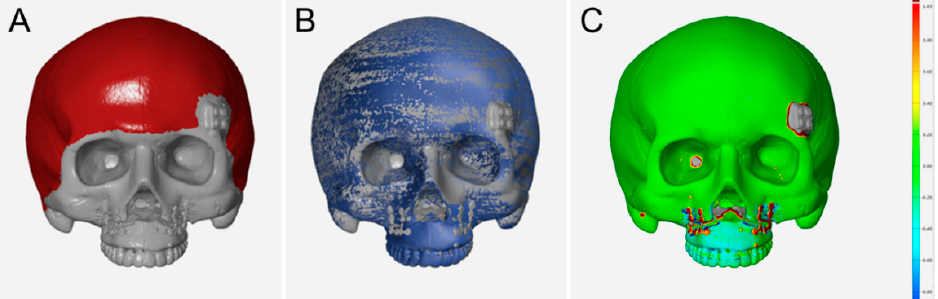
Figure 6. Superimposition of the postoperative 3D skull model registered with scanned dentition with the virtual surgical outcome. ( A ) Selection of the outer cortex of the cranium for local best-fit registration; ( B ) after superimposition of the two skull models; ( C ) surface comparison using a colored map.